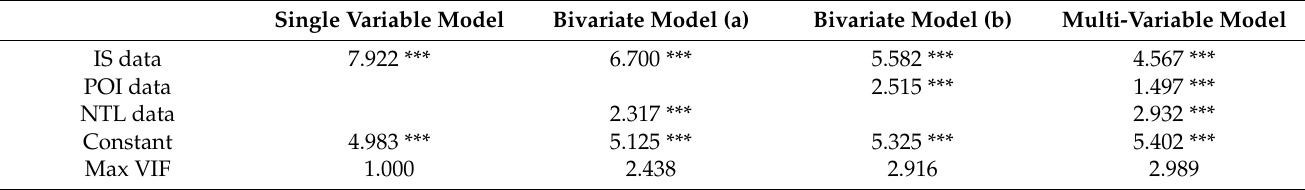
Table 4. The coefficients (on a log scale) of different types of models of variables and VIF (***—at the 1% level). Single Variable